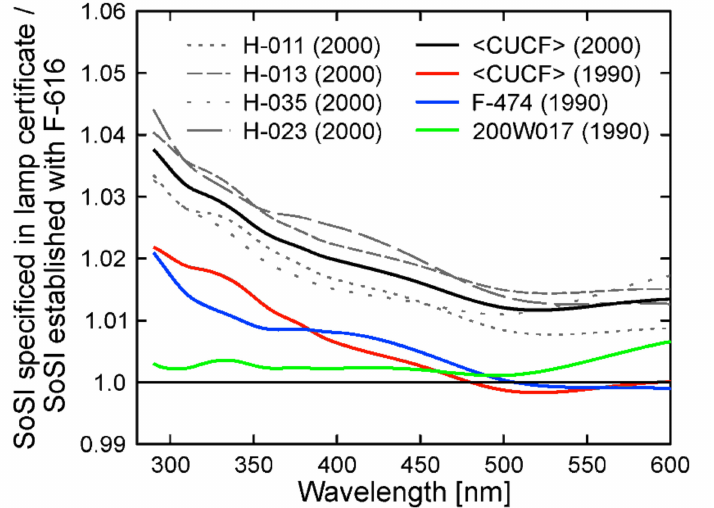
Figure A3. Ratios of the original SoSI of lamps indicated in the legend and the SoSI of these lamps established against standard F-616. Gray lines indicate ratios for the four CUCF standards using their original calibration against the NIST2000 scale. The black line indicates the average of these ratios. The red line is this average scaled to the NIST1990 scale. Lamp F-474 is a standard calibrated by NIST against the NIST 1990 scale and lamp 200W017 was the traveling standard at the time of the lamp comparison. It was originally calibrated against the NIST1990 scale of the CUCF